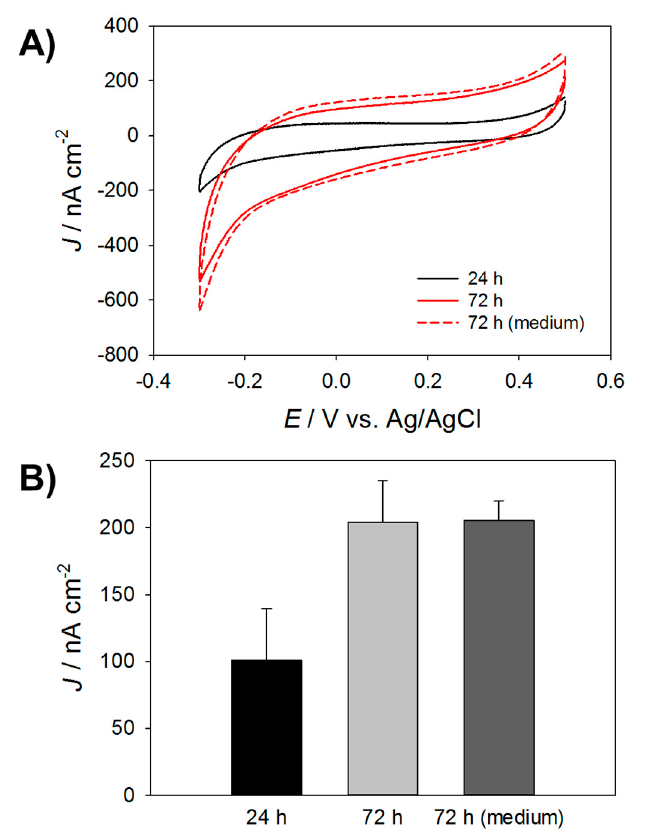
Figure 2. Evidence for secretion of electron shuttle by C. glutamicum . ( A ) Cyclic voltammograms of glassy carbon working electrode with C. glutamicum growth. ( B ) Total oxidation current by established C. glutamicum application (poised at +0.4 V vs. Ag/AgCl). The y-axis represents the mean value of each current density recording for 600 s. The current densities were measured after 24 h (with bacteria) and 72 h (with bacteria or cell-free medium).